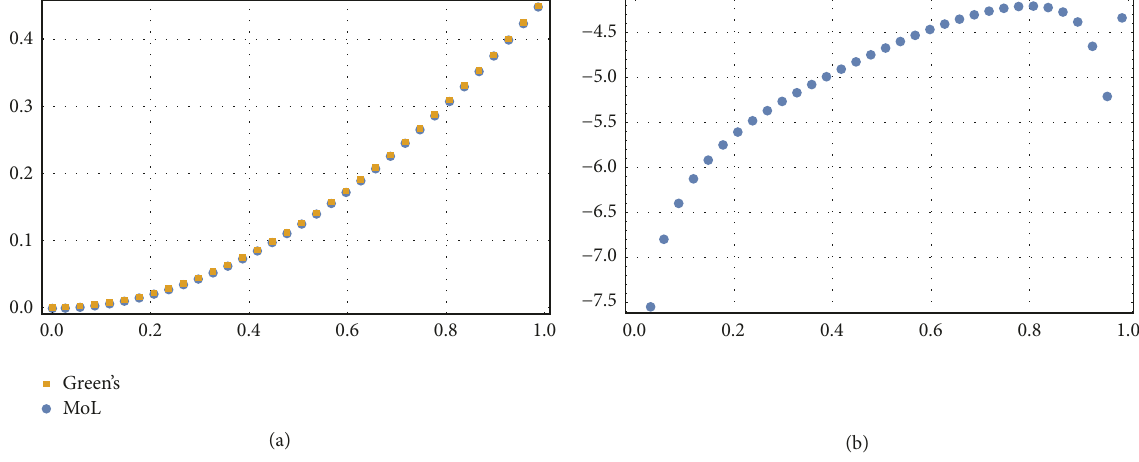
Figure 8: Discrete plot of 𝑤 and 𝑤 MoL (a) and Er (b) against 𝑡 ∈ [0, 1] for 𝑓(𝑡) = 𝜃(𝑡) : hyperbolic potential. Green’s